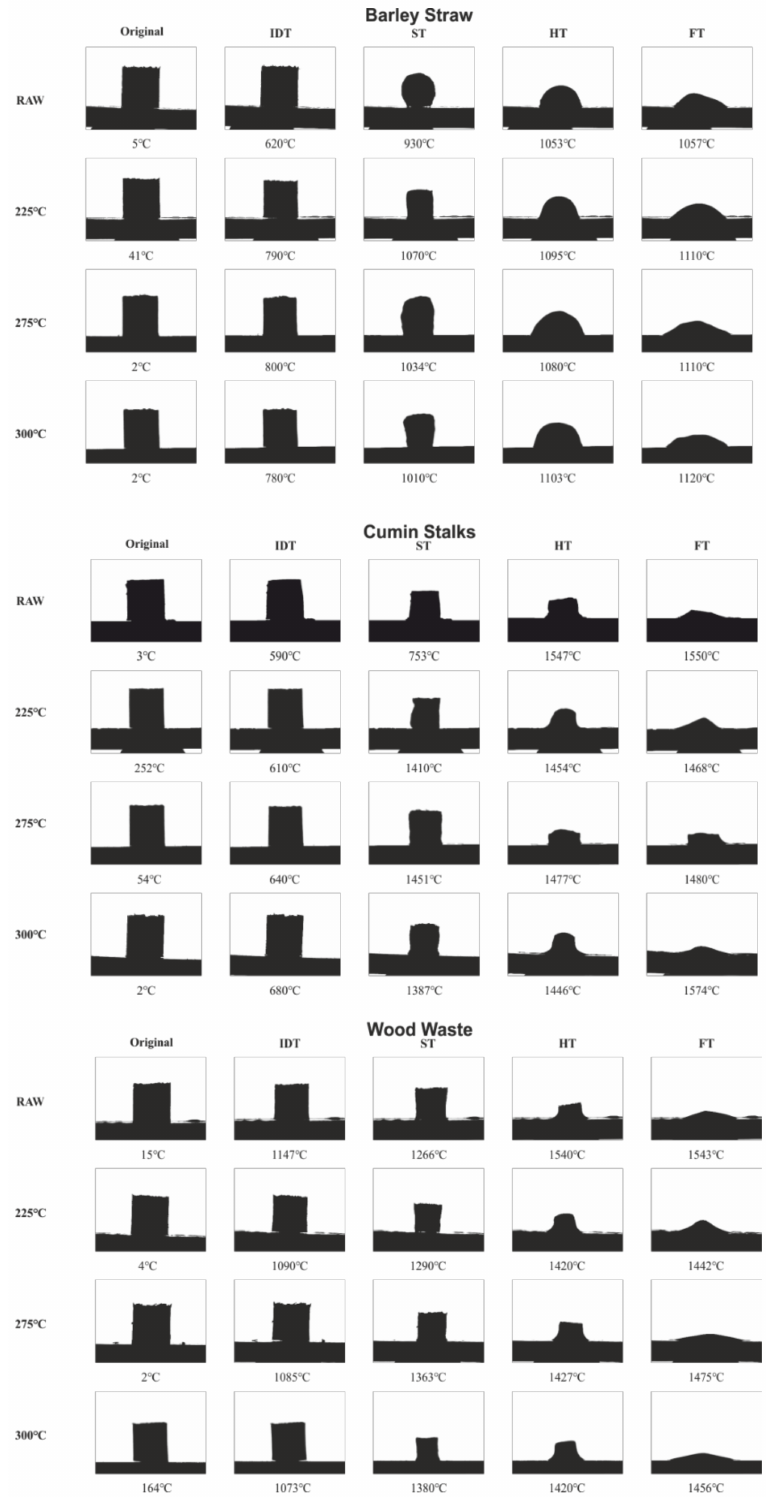
Figure 5. Ash melting temperatures of raw and torrefied